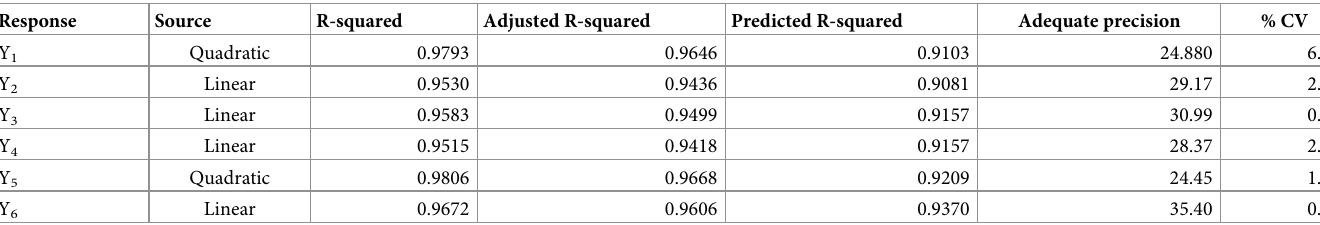
Table 5. Numerical test results of model adequacy checking for influence of independent variables on response variables.